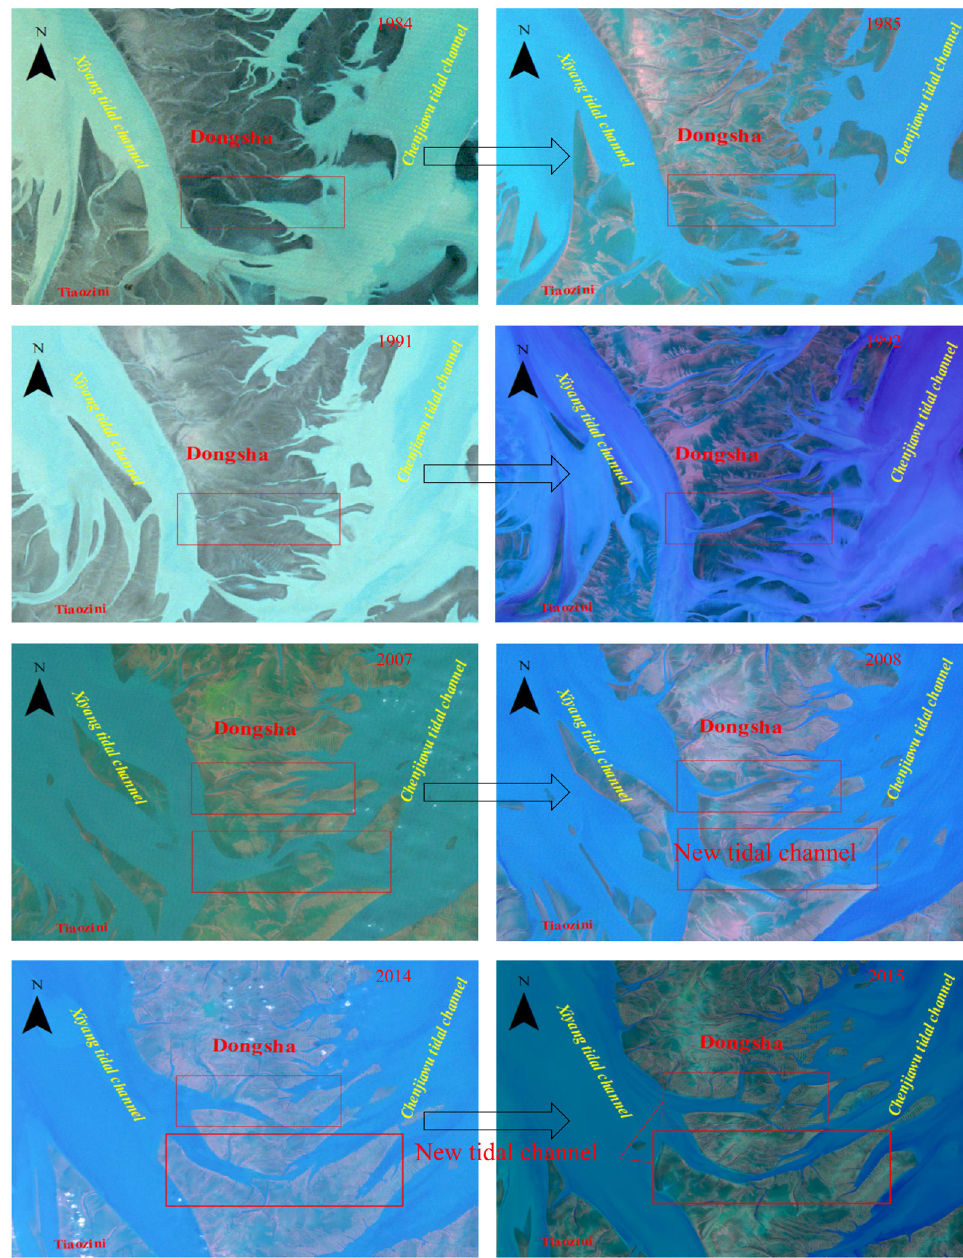
Figure 12. Several cases show the response of the Shaling Line to the typhoon.